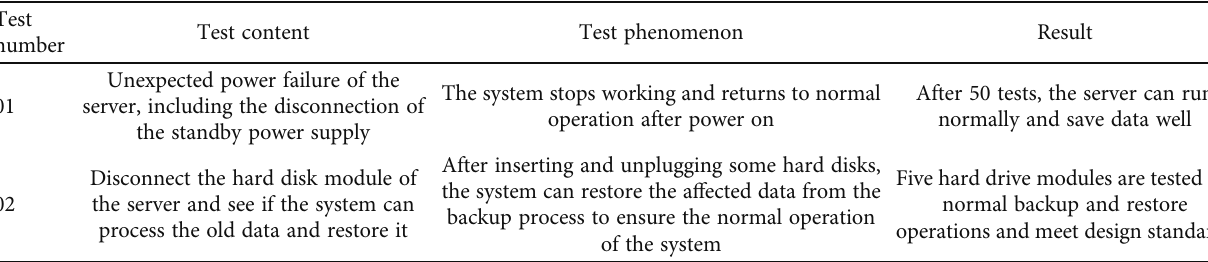
Figure 15: Analysis diagram of system database test results. Table 6: Analysis of physical security test